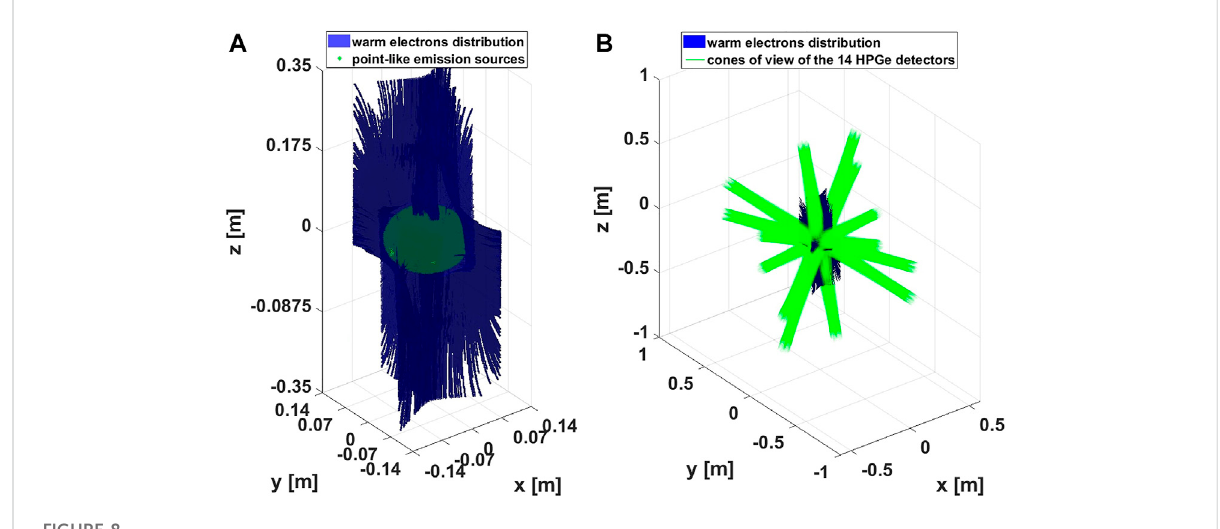
FIGURE 8 (A) : distributon of warm electrons (blu) superimposed to the simulated point-like sources of γ emissions (green). (B) : cones of view of the 14 HPGe detectors (green) crossing the warm electrons distribution